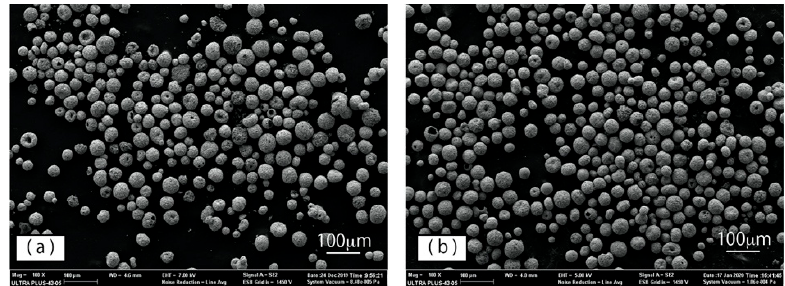
Figure 2. Morphology of WC–12%Co powders: ( a ) raw powder and ( b ) plasma-treated powder.